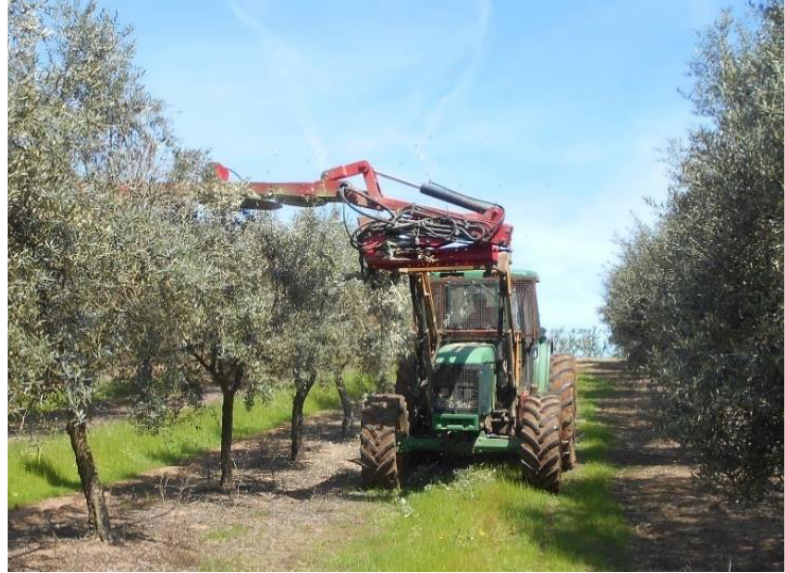
Figure 1. Mechanical pruning (topping).